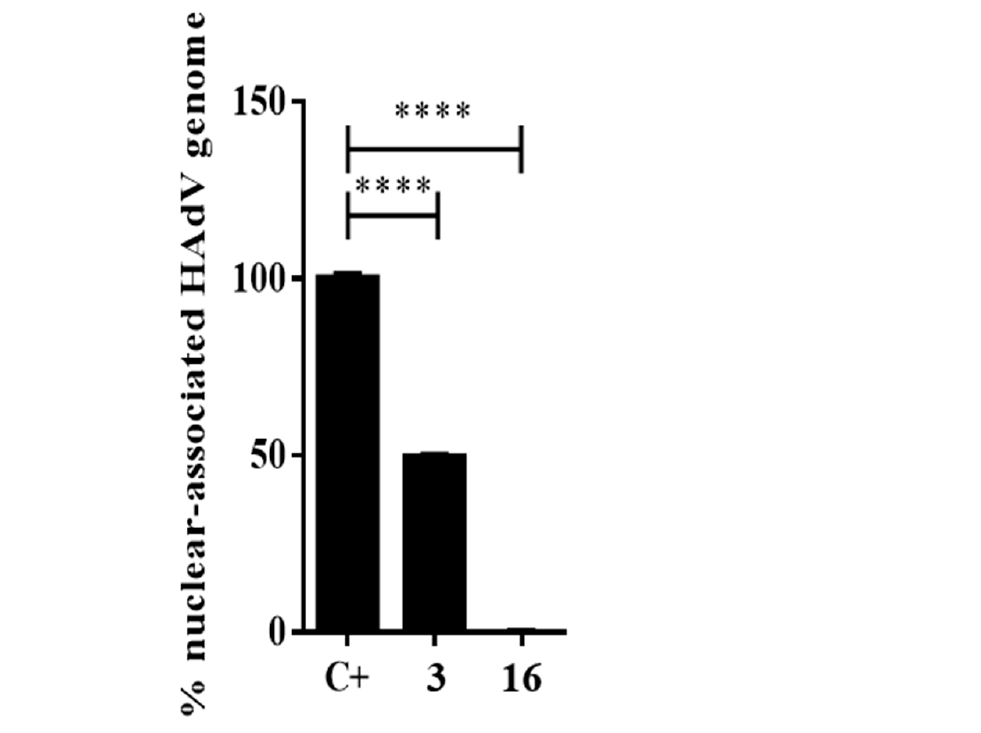
Figure 5. Percentage of nuclear-associated HAdV genome of compound 16 . Concentration of niclosamide (3) was 5 µ M and 10-fold IC 50 concentration obtained in the plaque assay for compound 16 . Bars represent means ± SD of triplicate samples. **** p ≤ 0.0001.